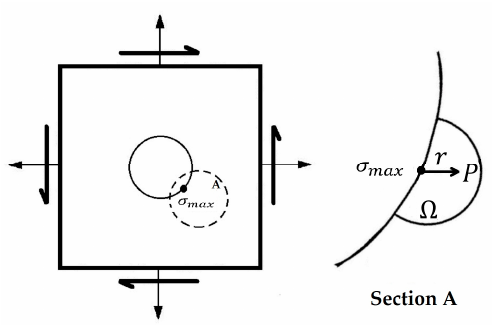
Figure 5. The diagram of the stress field intensity model. For elastoplastic materials like carbon steel, aluminum alloy, and titanium alloy, Von Mises equivalent stress, σ eq , is employed, whereas maximum major stress, σ max , is used for cast iron and cast steel. Additionally, the weight function 0 ≤ w ( r ) ≤ 1 physically